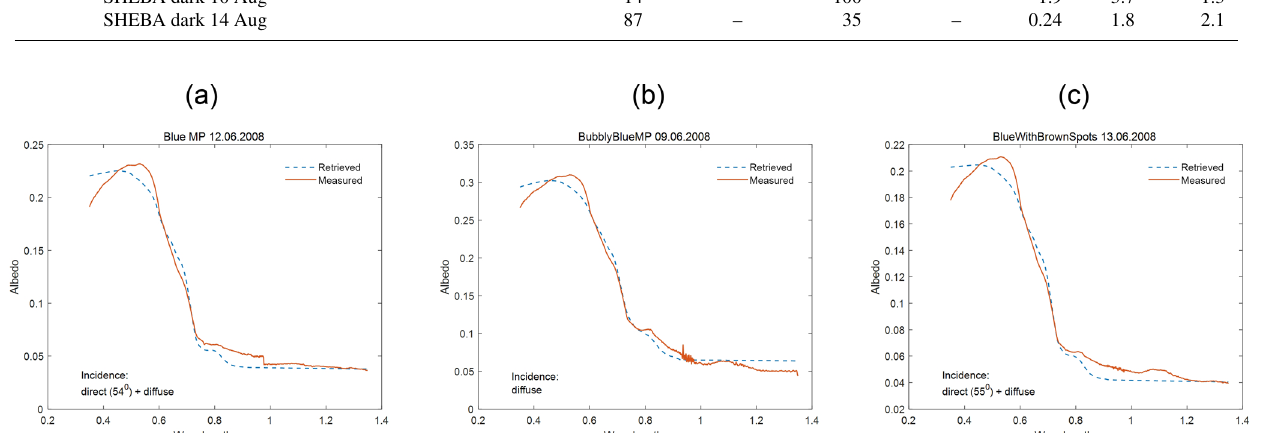
Figure 10. (a) A blue melt pond, (b) a bubbly blue melt pond, and (c) a blue melt pond with brown spots. Barrow-2008.